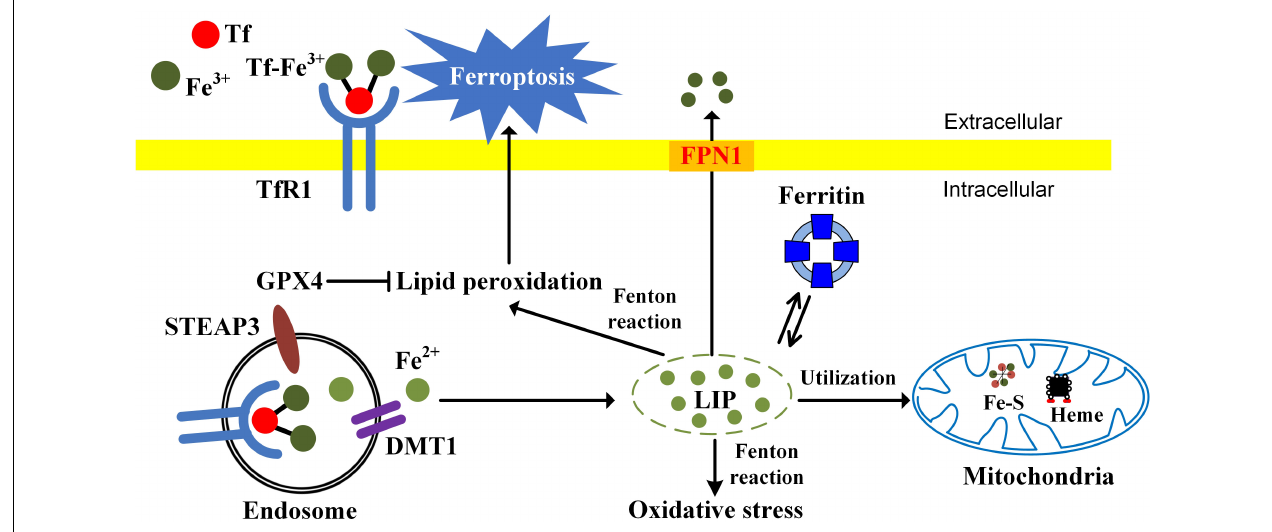
FIGURE 1 | The relationships among iron, oxidative stress, and ferroptosis. TfR1-mediated iron uptake is the major way for iron acquisition by most mammalian cells. When Tf binds to the cell-surface TfR1, the complex is internalized by receptor-mediated endocytosis. Ferric iron is then released and reduced to the ferrous state by ferrireductase STEAP3. After that, Fe 2 + is transported into the cytosol from the endosome by DMT1. In mitochondria, iron is utilized for the synthesis of Fe-S clusters and heme. Ferritin is the major iron-storage protein. Cellular free iron catalyzes the formation of ROS and causes oxidative stress via Fenton reaction. The excessive iron-dependent generation of lipid peroxidation can lead to